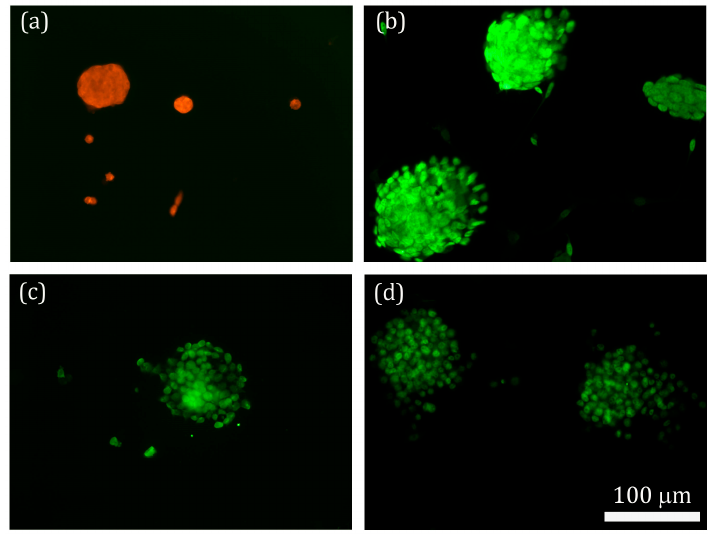
Figure 5. iPSCs were identified by immunofluorescent staining for: stage-specific mouse embryonic antigen (SSEA-1) ( a ); SOX2 ( b ); Nanog ( c ); and Oct4 ( d ).